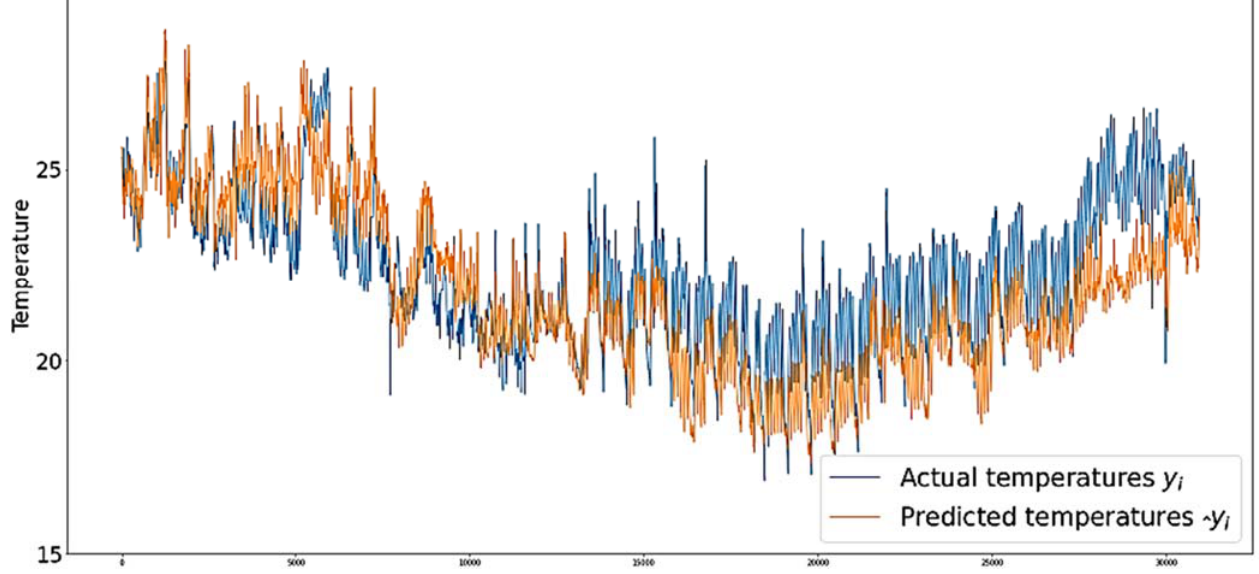
Figure 17. Plot of actual and predicted temperatures 2 h ahead for office 40 on the second floor.